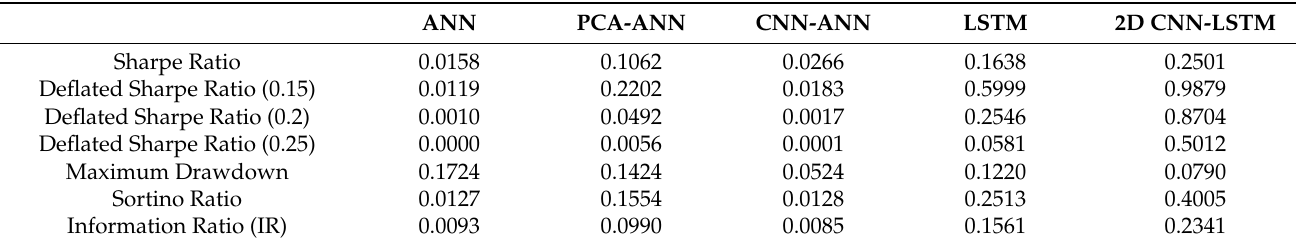
Table 14. The Amount of Each Measure with Five-Day-Ahead Forecast.